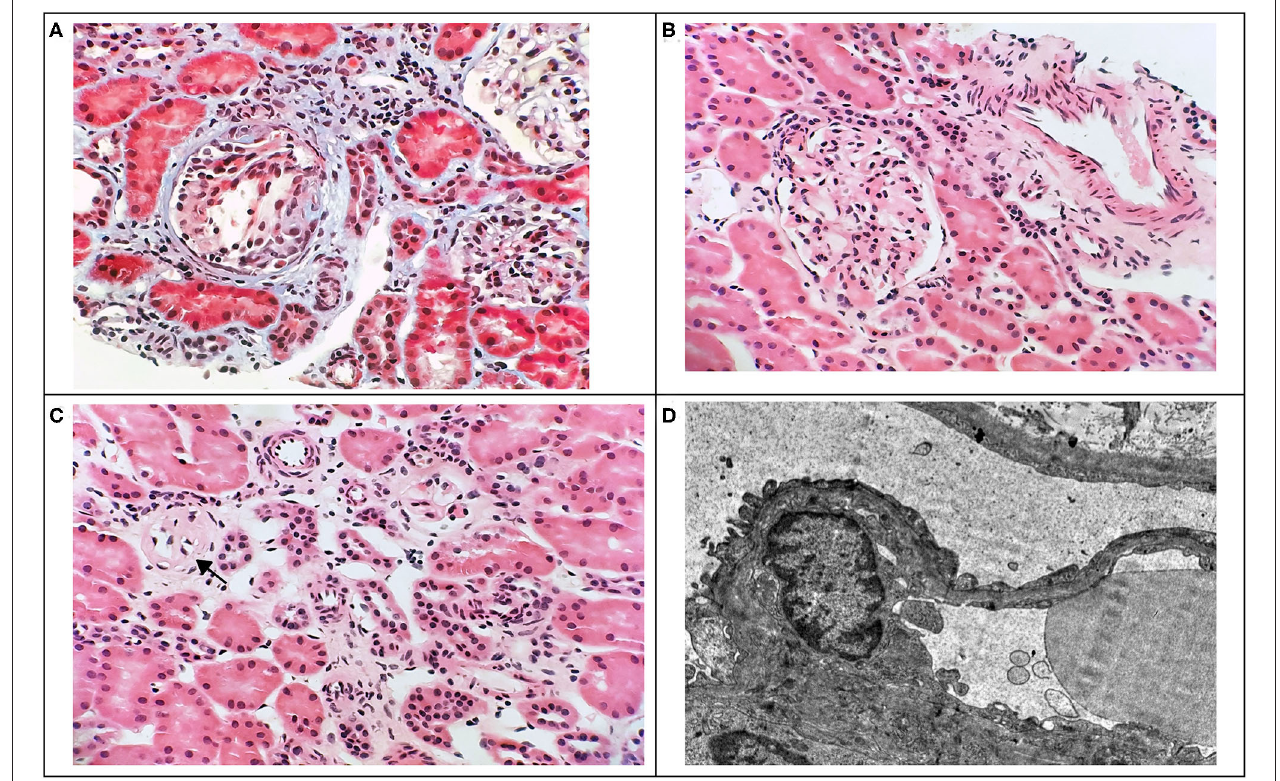
FIGURE 1 | Renal biopsy findings. Light microscopy of renal tissue showing glomerular tuft collapse with podocyte hypertrophy (A) , focal segmental mild mesangial hypercellularity (B) , and global glomerulosclerosis (C) with mild focal interstitial fibrosis and mild lymphocytic interstitial infiltrate (A,C) . ( A : Masson’s trichrome, x400; B,C : HE, x400). Electron microscopy image of renal tissue (D) showing foot processes effacement